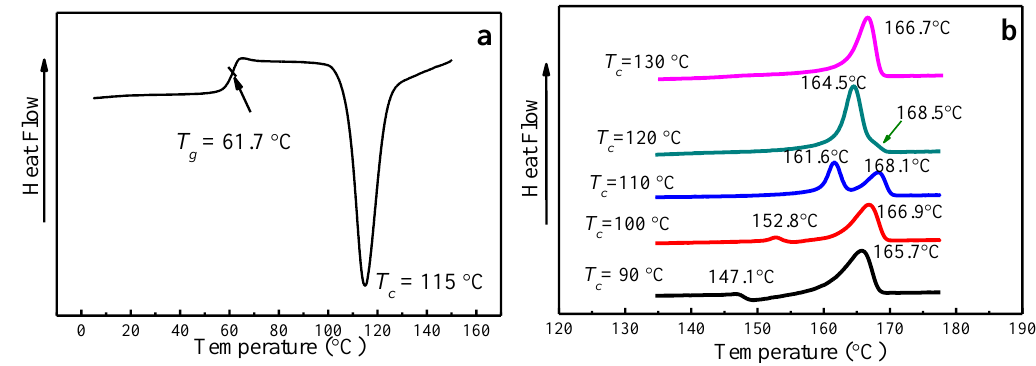
Figure 3. Differential Scanning Calorimetry (DSC) analysis showing ( a ) T g of amorphous PLLA and ( b ) melting characteristics of PLLA samples melt-crystallized at different T c .